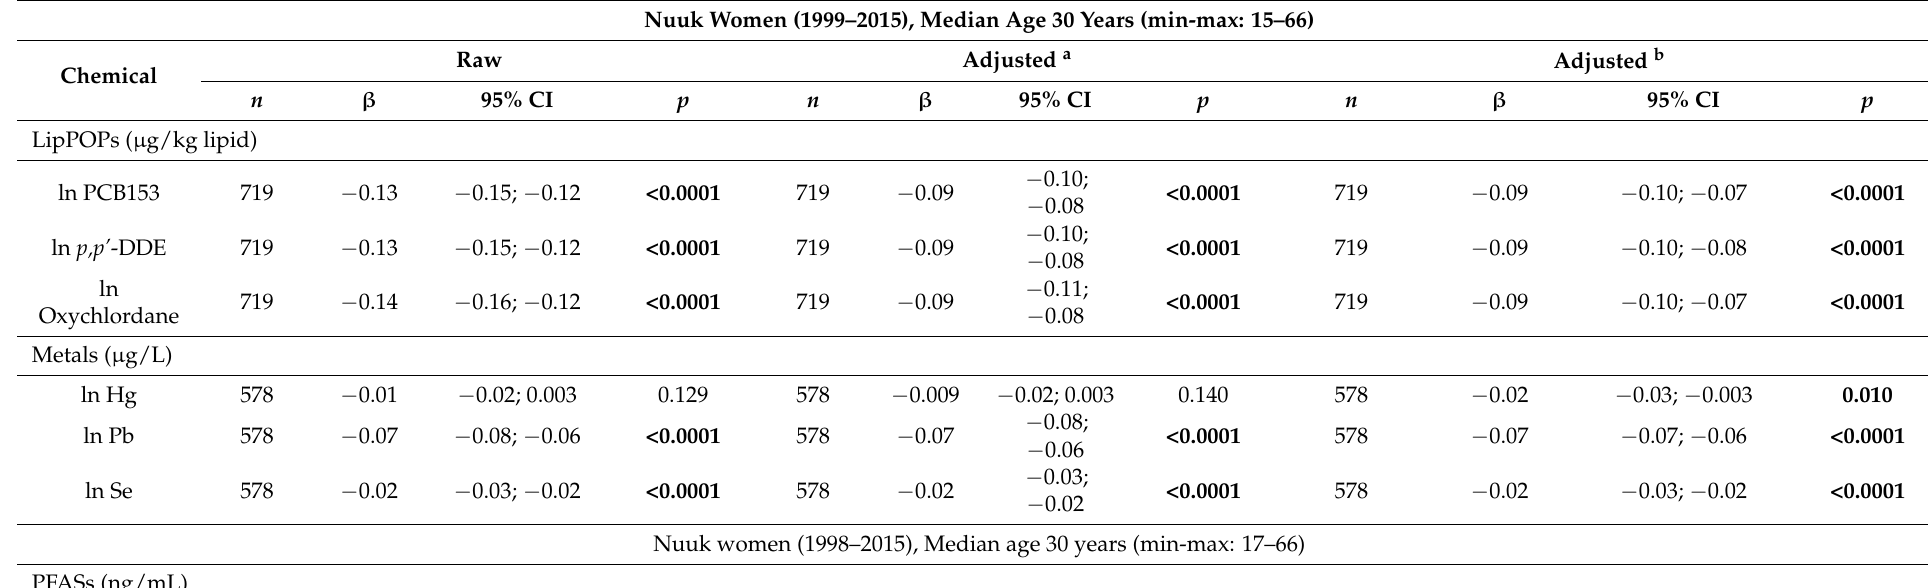
Table 3. Women in Nuuk and Ilulissat: Time trend of lipPOPs, metals and PFASs